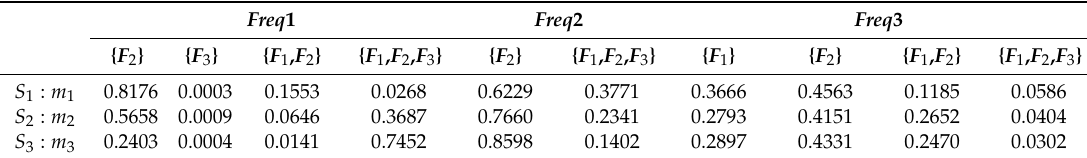
Table 3. The obtained BPAs.